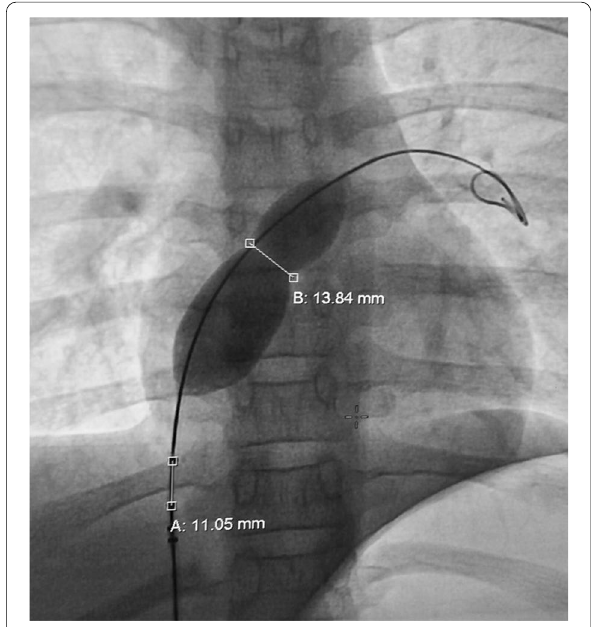
Fig. 3 Sizing balloon showing indentation on fluoroscope once inflated with diluted saline contrast after positioning it across the defect and indentation was measured